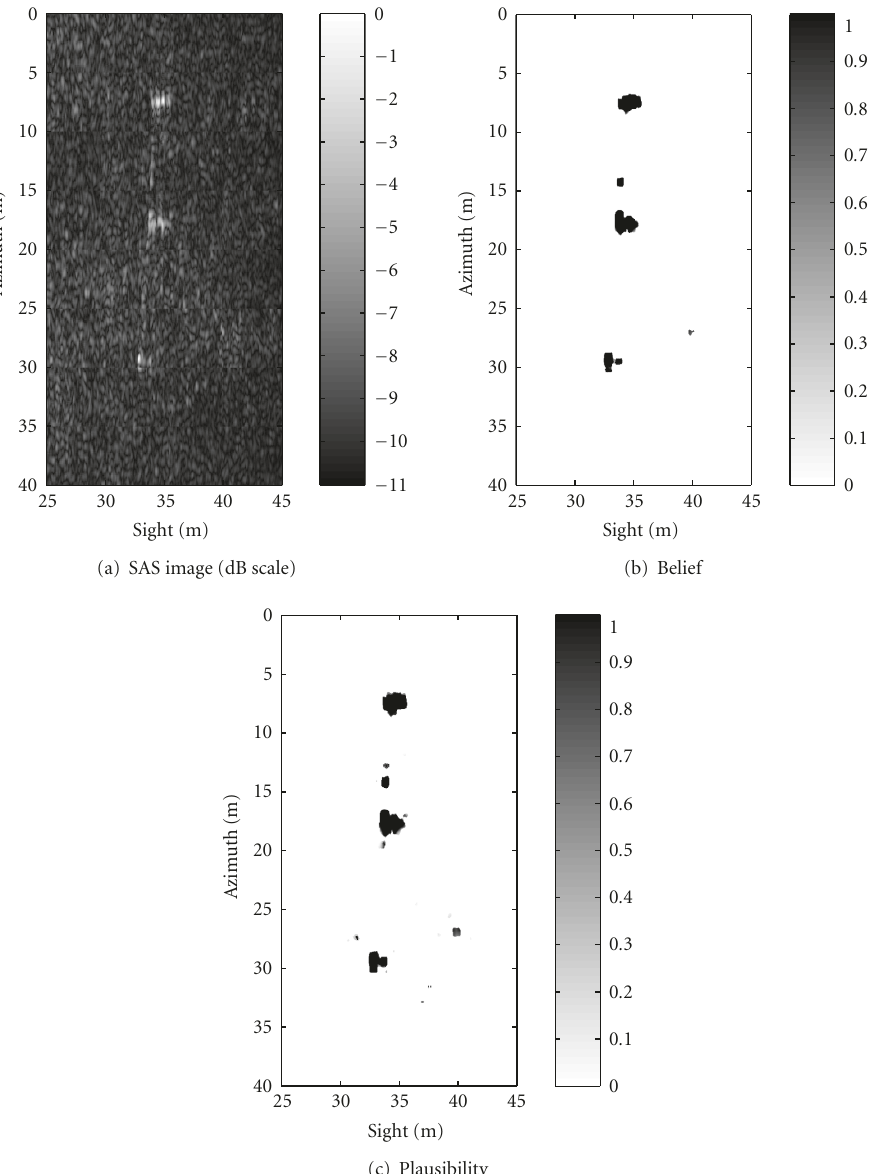
Figure 20: Belief and plausibility images obtained after fusion of the three parameters in image